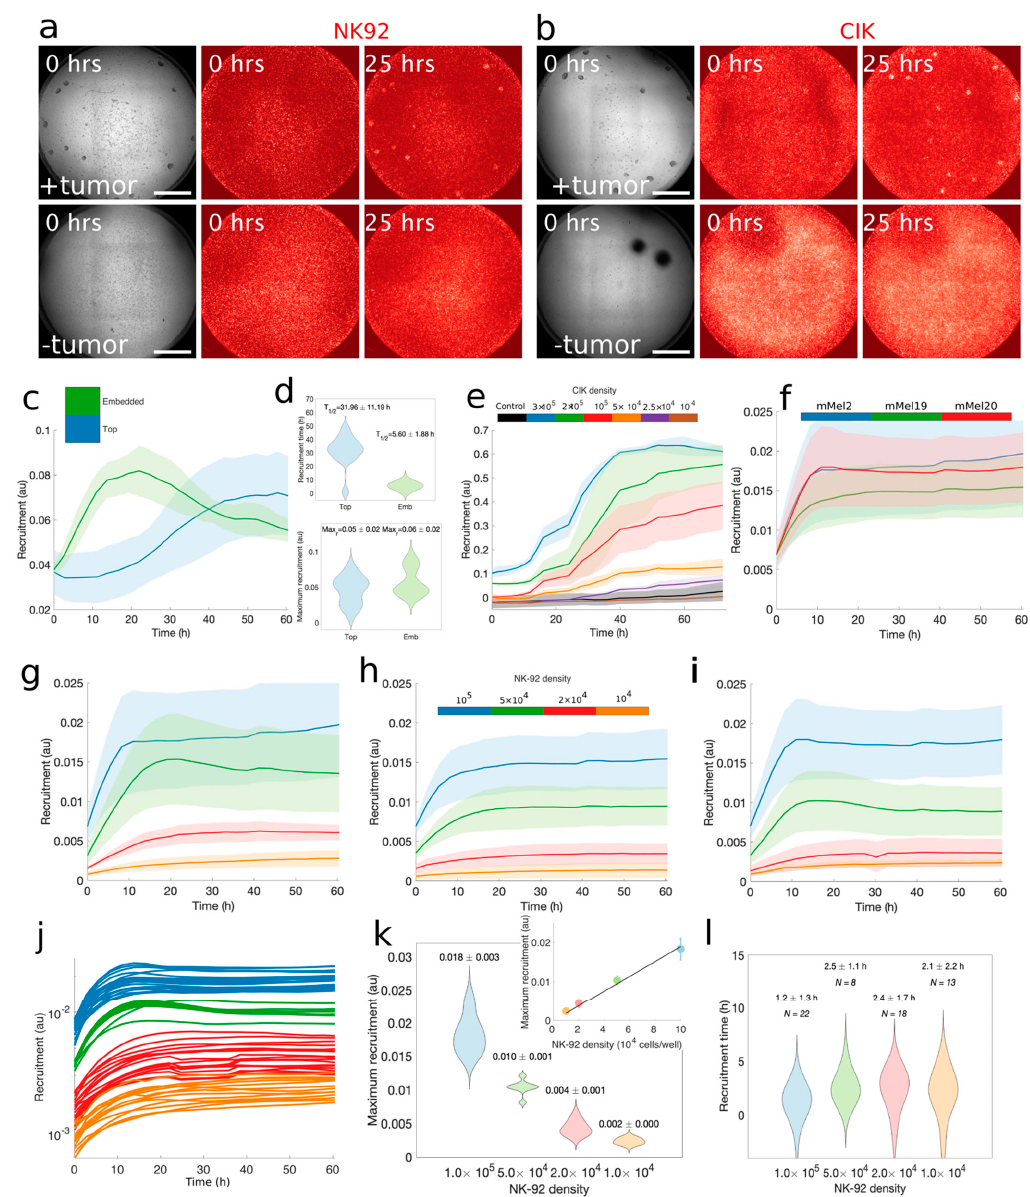
Figure 2. Homing of immune effector to target in 3D melanoma. ( a , b ) NK92 and CIK cells were embedded in collagen and were monitored by time-lapse imaging with (top rows) and without (bottom rows) target. The images correspond to two snapshots at indicated times for brightfield and fluorescent channels corresponding to excitation of PKH26, which labels effectors only. No clustering at the scale of target emerged. Scale bar: 500 μ m. ( c ) CIK cells were embedded into a collagen matrix (green) or were seeded on top of the matrix (blue) and were monitored by time-lapse imaging. Recruitment in this and in the following panels and plots was measured as the intensity of fluorescence signal in the regions of the image corresponding to the spheroids. The plot shows the recruitment of effector cells on mMel19 spheroids at different times after the addition of CIK. Each line represents the average of many single spheroids ( N = 14; N = 23 for top and gel seeding, respectively), while shades represent standard deviation. ( d ) Quantitative analysis obtained from recruitment data: (top) recruitment time extracted by fitting the recruitment time sequences as fluorescent signal localized onto the tumor spheroids for CIK seeded on top (blue) or mixed in the gel (green). Mean and dispersions were (31.96 ± 11.19) h for top-seeded CIK ( N = 14 spheroids), compared with CIK cells embedded in the collagen (in green, (5.6 ± 1.88) h, N = 23 spheroids).